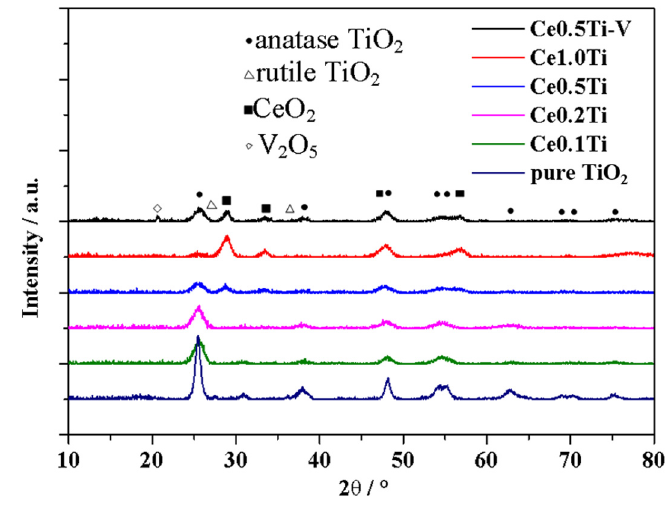
Figure 7. Crystalline structures of the catalysts.